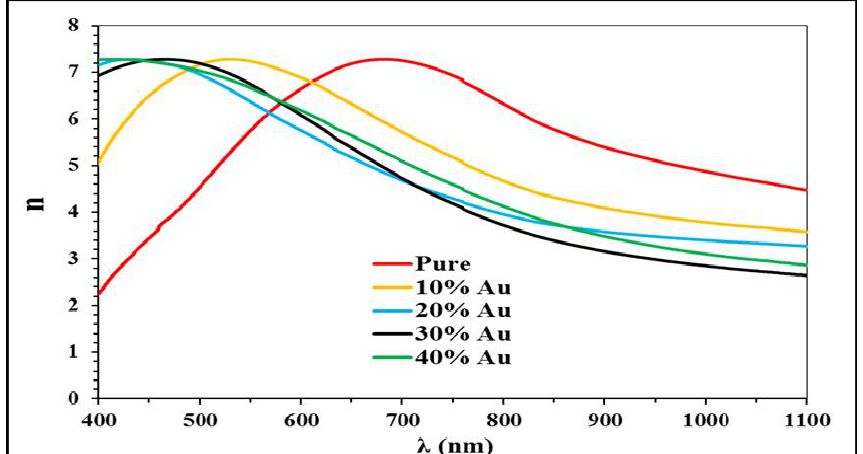
Fig. 14: Refractive index for pure WO